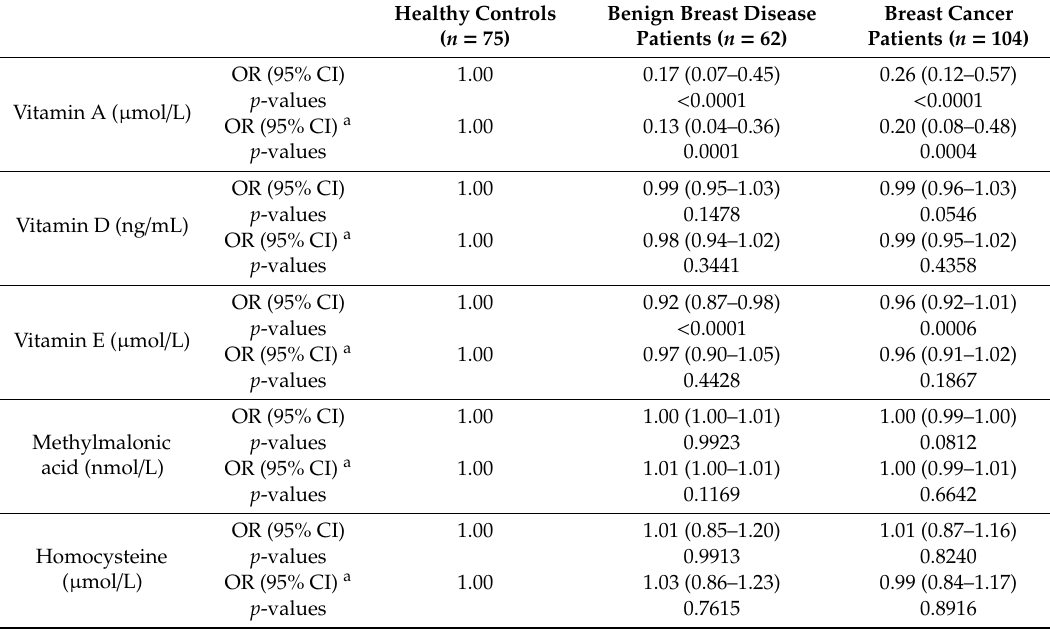
Figure 1. Comparison of vitamins and vitamin B12 status indicators between healthy controls, patients with benign breast disease, and patients with breast cancer. ( a ) vitamin A, ( b ) vitamin D, ( c ) vitamin E, ( d ) methylmalonic acid, and ( e ) homocysteine. Abbreviations: NS, not significant; HC, healthy controls; BBD, patients with benign breast disease; BC, patients with breast cancer. Table 3. Crude and adjusted estimated odds ratios for breast cancer and benign breast disease (and 95% confidence intervals) associated with serum levels of vitamin status markers (multivariate logistic regression